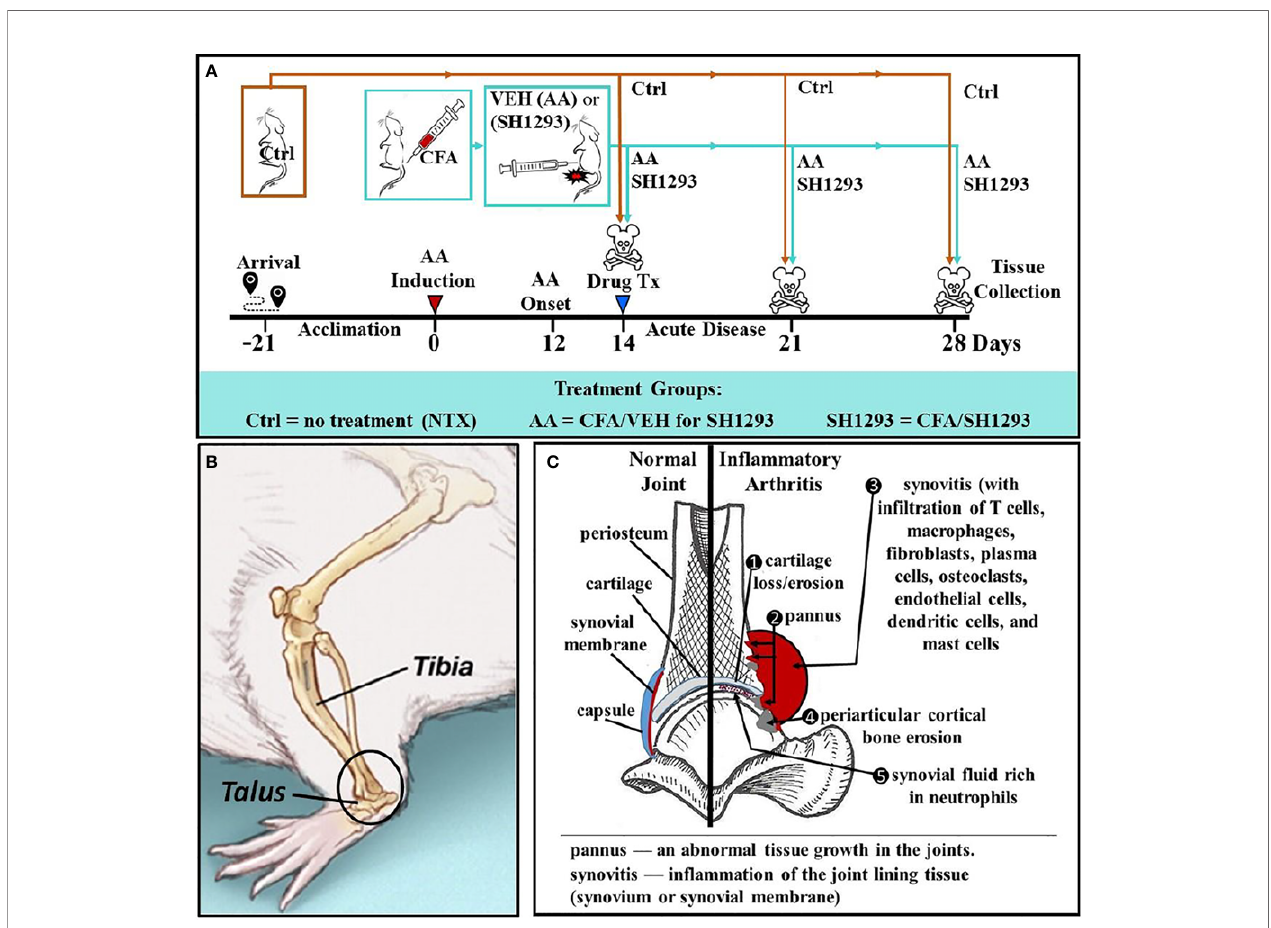
FIGURE 1 | Experimental Design across Time (A) , Illustration of the Talocrural Joint (B), and Joint Pathology in IA (C) . (A) After acclimation to vivarium conditions for 21 day, arthritis was induced on D0 by injection of complete Freund ’ s adjuvant (CFA) into the base of the tail of young adult male Lewis rats to induce arthritis. Control rats (Ctrl) received no treatment. At D12, arthritic rats received the vehicle for SH1293 (AA) or SH1293. Rats were sacri fi ced D21 or D28 after disease induction and tissues were harvested. (B) A lateral view of the rat hind limb illustrates the talocrural joint formed by the distal tibia and talus. The region of interest (ROI) in this study is indicated in the open black circle. (C) As illustrated, arthritis-induced joint pathology was assessed in this study, including cartilage, bone erosion, and osteoclast number (1, 4), pannus formation (2), synovitis and cellular in fi ltration (3, 5). The density of sympathetic nerves was evaluated using the rate- limiting enzyme for norepinephrine synthesis, tyrosine hydroxylase, as a marker for these